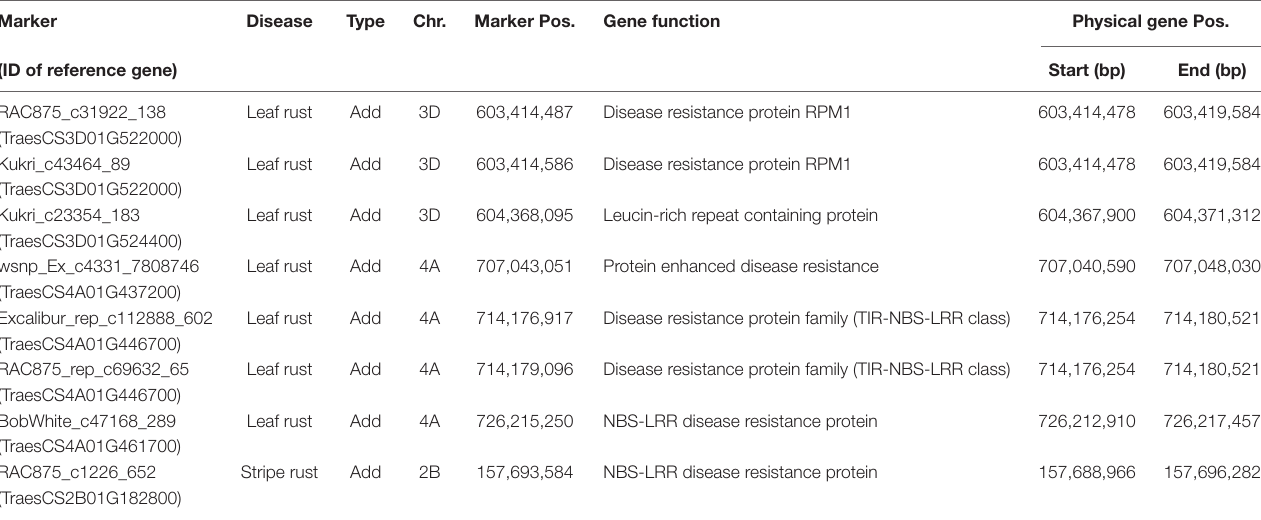
TABLE 3 | Comparison of detected markers with a significant effect on leaf rust and stripe rust resistance with the location of previously known resistance genes within the reference genome. Marker Disease Type Chr. Marker Pos. Gene function Physical gene Pos.